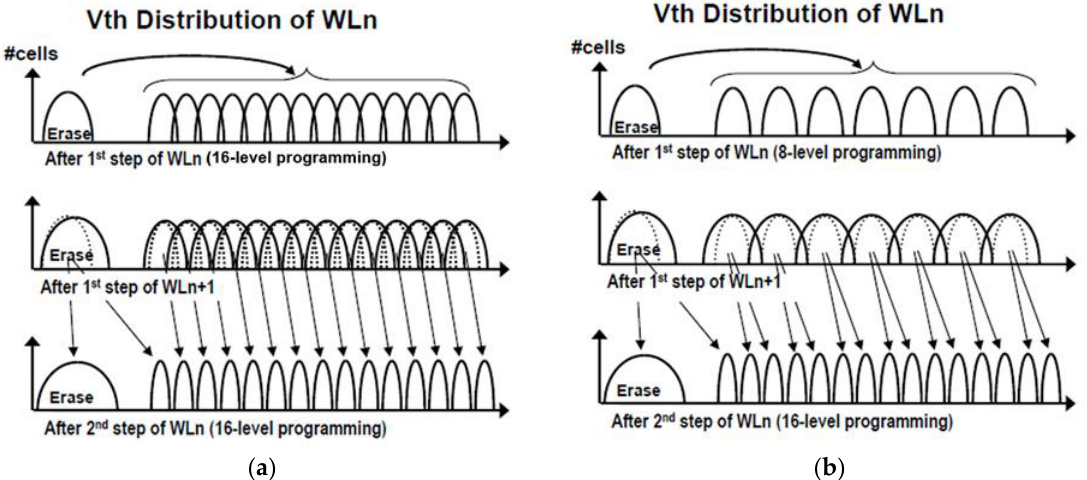
Figure 22. QLC coarse – fine programming schemes with ( a ) 16-16 scheme and ( b ) 8-16 scheme. 16-16 is more efficient to compensate the short-term retention while the 8-16 scheme would have tProg advantage. Reprinted with permission from ref. [26], Copyright 2019 IEEE.